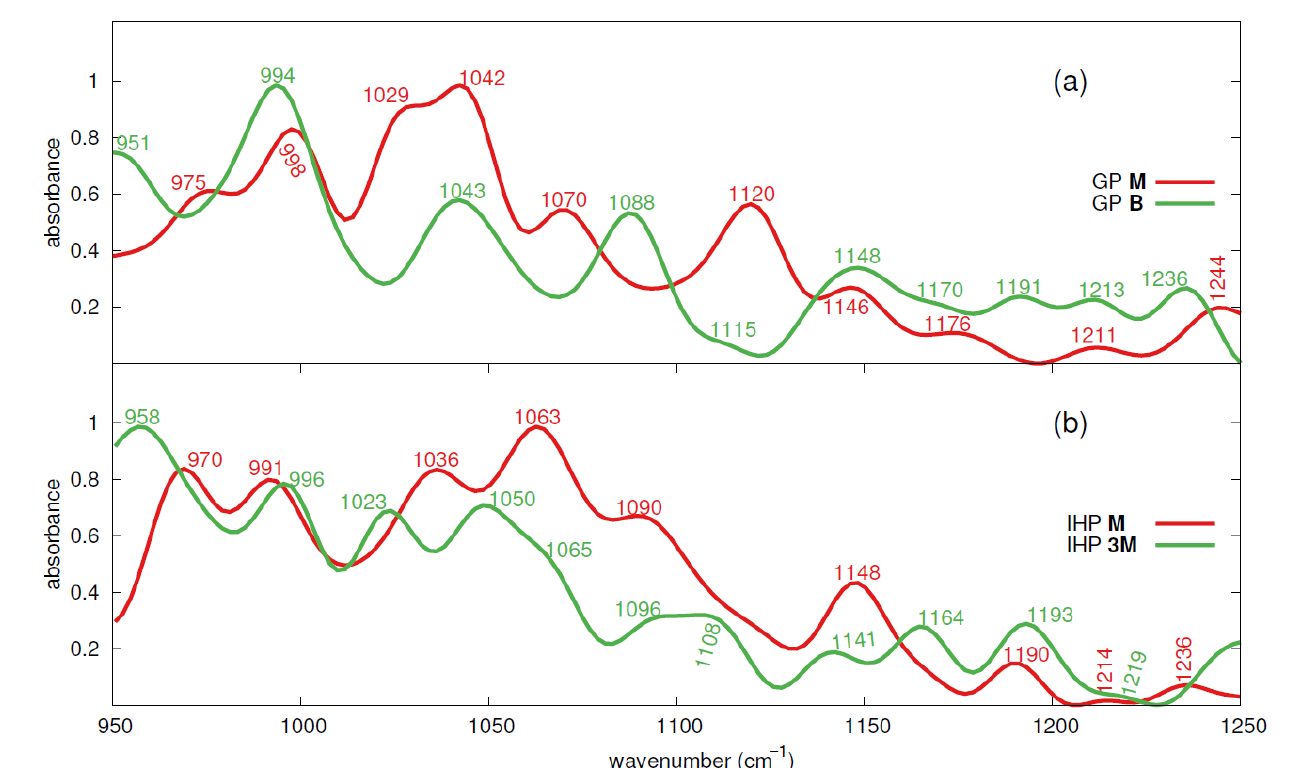
Figure 5. Calculated IR spectra of GP M and B motifs ( a ) and IHP M and 3M motifs ( b